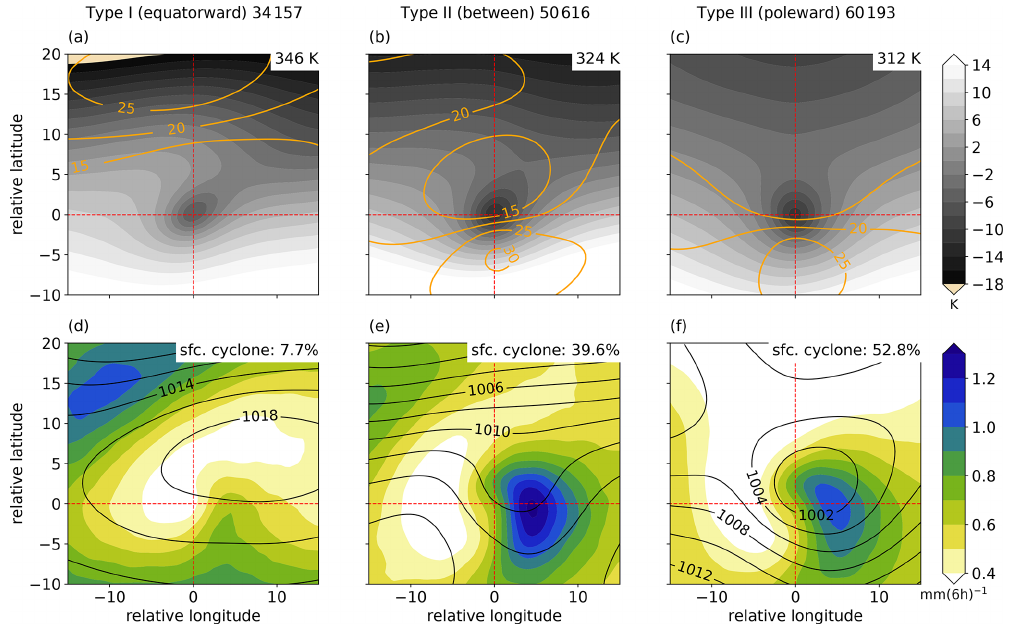
Figure 8. Cutoff-centered composites of (a–c) equivalent potential temperature at the 2PVU isosurface (shading, in K, given as difference from the domain mean value indicated at the top right of each panel) and zonal wind speed at 300hPa (orange contours, in ms − 1 ), and (d–e) total precipitation (shading, in mm ( 6h ) − 1 ) and sea level pressure (black contours, in hPa) at PV cutoff genesis, individually for (a, d) Type I, (b, e) Type II, and (c, f) Type III. The total number of tracks of each type is indicated at the top of panels (a) – (c) . Additionally, the percentage of PV cutoffs linked to a surface cyclone during their life cycle is indicated for each type at the top right of panels (d) – (f)